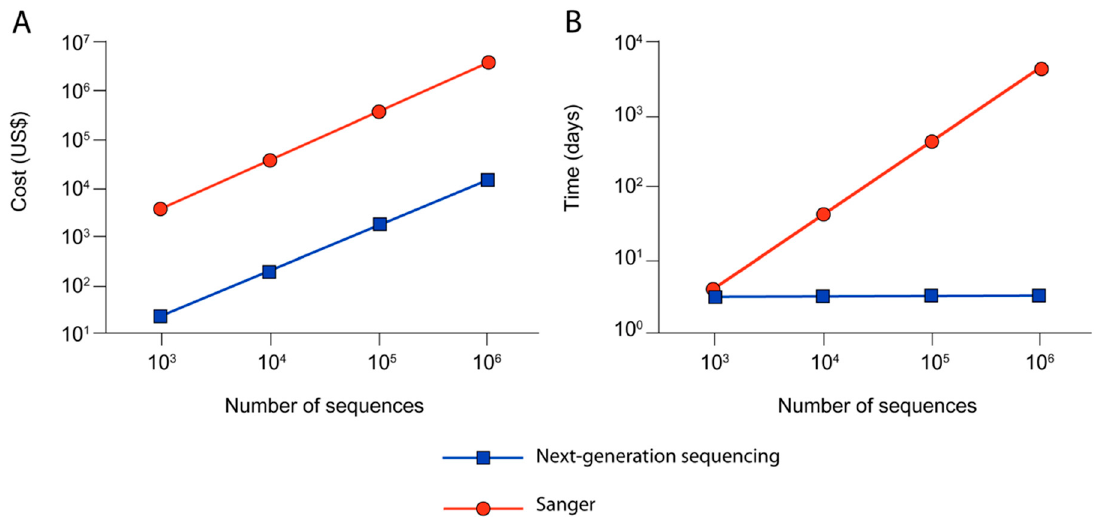
Figure 4. These graphs demonstrate how ( A ) cost and ( B ) time necessary for phage sequencing decreases when using next-generation sequencing (blue) over traditional Sanger sequencing (red) for increasing numbers of sequences. Images modified from [15] and used with permission from PLoS